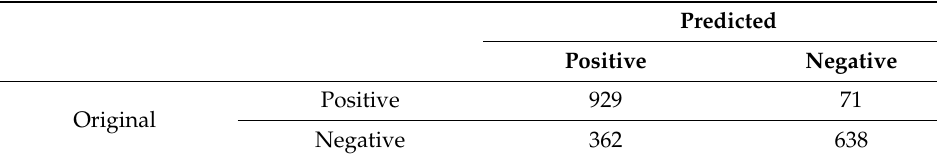
Table 13. Confusion matrix for ontology baseline approach.